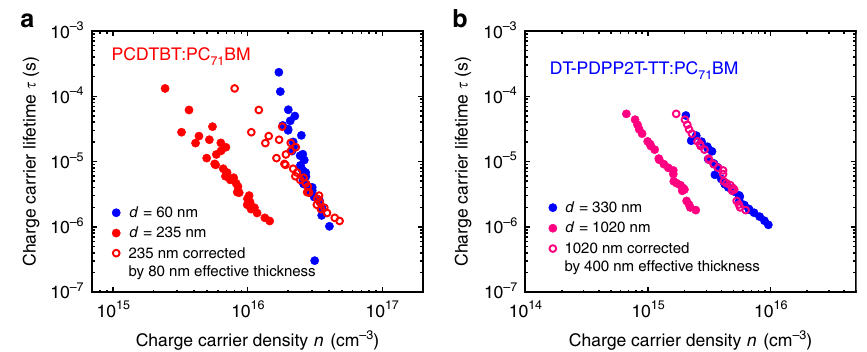
Fig. 3 Evaluating the effective thickness. Recombination kinetics analysis of thick and thin devices of ( a ) PCDTBT:PC 71 BM devices and ( b ) DT-PDPP2T-TT: PC 71 BM, indicative of the effective thickness around 80 nm and 400 nm, respectively